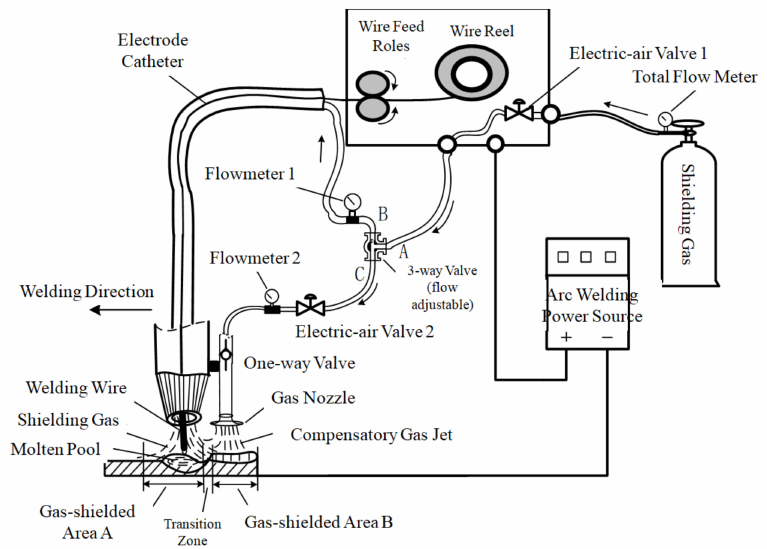
Figure 2. Schematic of the molten pool blown with compensatory gas jet during welding.